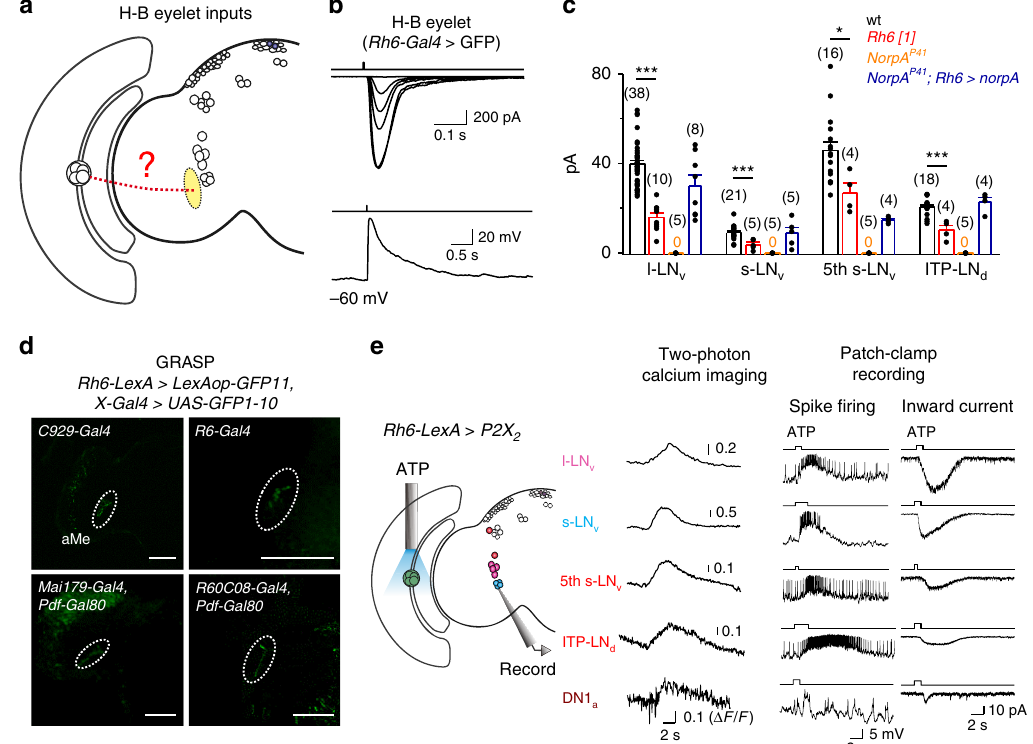
Fig. 6 Monosynaptic visual inputs from H – B eyelets to pacemaker neurons. a Schematic illustration of H – B eyelet inputs to the central pacemaker neurons. b Response properties of H – B eyelet photoreceptors. Top, light elicits inward currents that produce graded depolarization of H – B eyelet photoreceptors. Bottom, no spike fi ring in H – B eyelet photoreceptors to light-induced depolarization under current clamp. c Collective data of light responses in pacemaker neurons of the different fl ies as indicated. 0 indicates no responses at all. Cell numbers are indicated in brackets; error bars represent SEM; * P < 0.05; *** P < 0.001. d Close contacts between H – B eyelet photoreceptors and different pacemaker neurons revealed by GRASP. The aMe is marked by dashed circles. Scale bar: 50 μ m. e H – B eyelets excite pacemaker neurons. Left, illustration of H – B eyelet activation by ATP. Middle, two-photon GCaMP6m imaging of pacemaker neurons in response to the ATP activation of H – B eyelets. Right, electrical responses of pacemaker neurons. ATP: 2.5